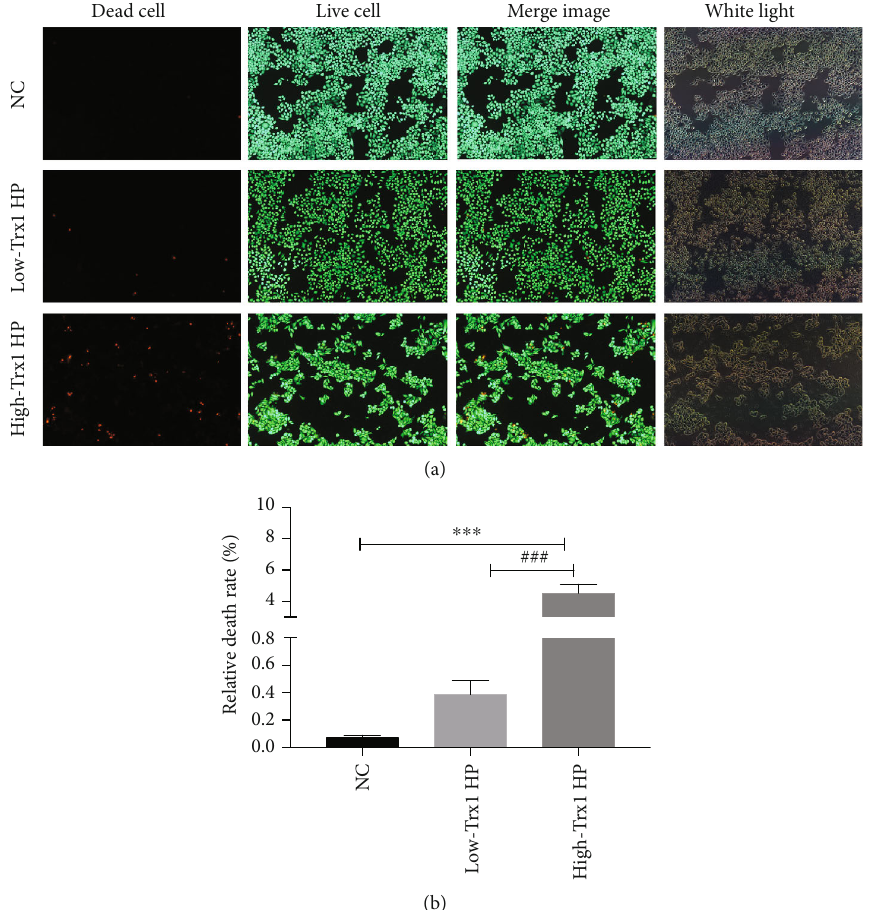
Figure 2: The high-Trx1 HP can cause higher mortality of GES-1 cells. (a) Fluorescence staining of living and dead cells after coculture with low-Trx1 HP or high-Trx1 HP in GES-1 cells. (b) Statistics of dead cells after cocultured with low-Trx1 HP and high-Trx1 HP in GES-1 cells. Note: dead cell means dead cell staining, live cell means live-cell staining, merge image means dead and live cell staining image merging, white light means cell image under bright fi eld, NC means uninfected control group, low-Trx1 HP means HP with low Trx1 expression, and high-Trx1 HP means HP with high Trx1 expression, ∗∗∗ P < 0 : 001 , ### P < 0 : 001